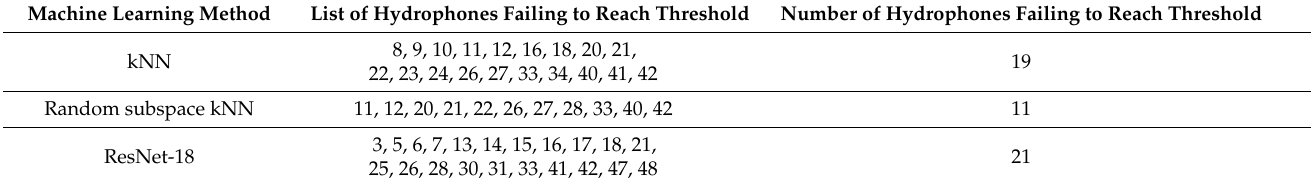
Table 3. Lists of hydrophones failing to reach the threshold of 0.9 using three kinds of machine learning methods (kNN, random subspace kNN and